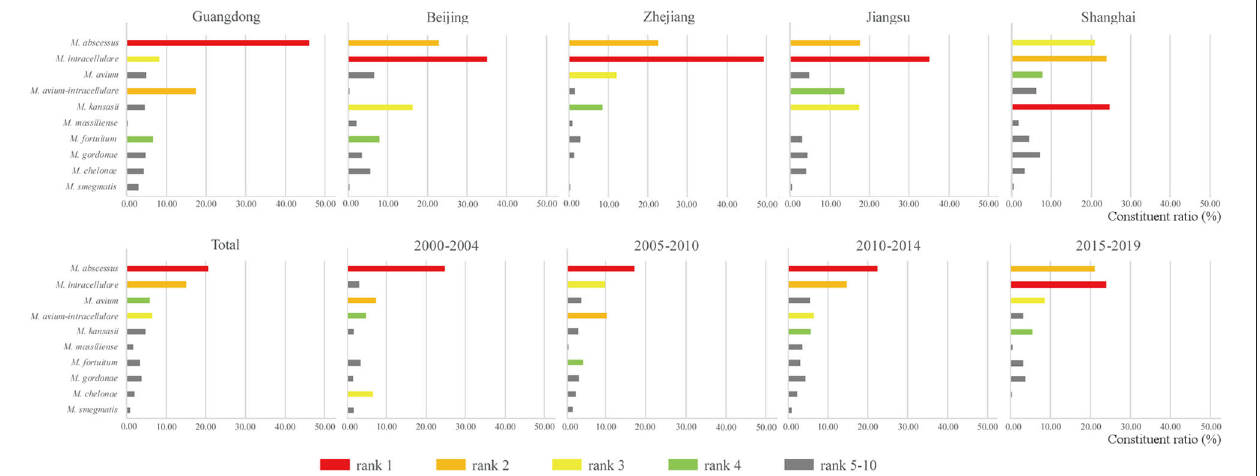
Bone and joint Eye infection infection infection